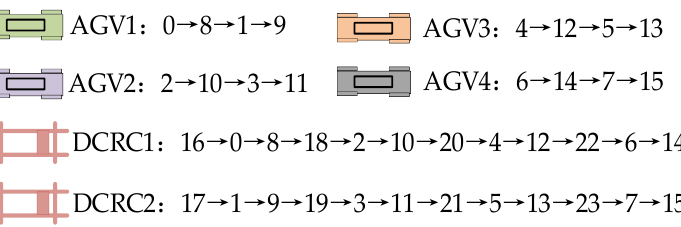
Figure 6. Sequence of tasks represented by the initial chromosome.